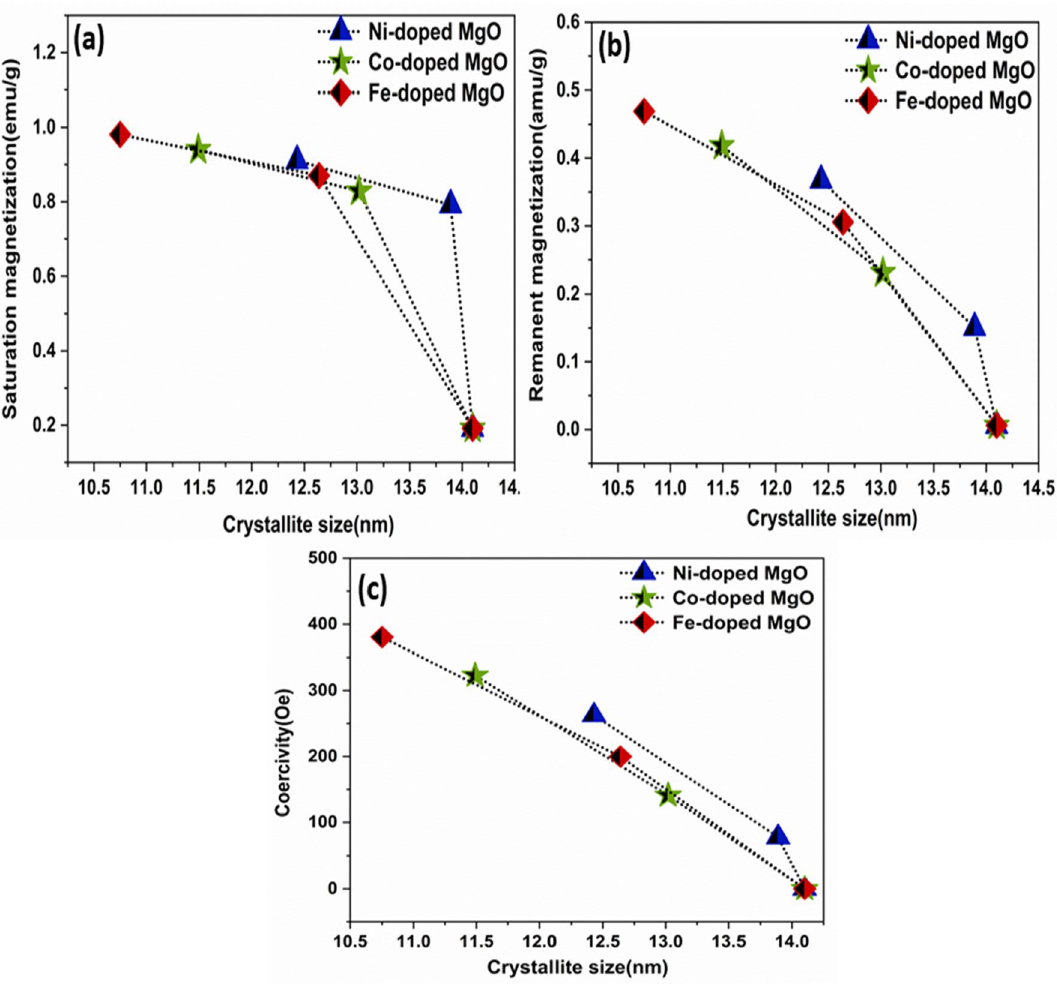
Figure 13. The Correlation between the crystallite size and ( a ) Ms, ( b ) Mr, ( c ) Hc of Ni , Co , and Fe-doped MgO nanoparticles with the various doping concentrations of 0%, 3% and A scale in mm was used to measure the inhibition zone diameters, which had appeared around each filter paper disc. At doses 20 and 30 μg/ml of nanoparticle suspensions, there was no inhibition zone against E. coli (gram-negative) and S. aureus (gram-positive). Still, the inhibition zone was observed around each filter paper disk against E. coli and S. aureus at dose 40 μg/ml of nanoparticle suspensions as shown in Figs. 15 and 16. The differences measured of inhibition zone diameter around the filter paper disk might be attributed to many factors such as the amount of the nanoparticle concentrations suspension, size of nanoparticles, the type of the materials, and resistance of bacteria on antibacterial. The average inhibition zone diameter at 40 μg/ml and 80 μg/ml of Ni, Co, and Fe-doped MgO nanoparticles against E. coli were listed in Tables 4 and 5, respectively, as shown in Figs. 17 and 18. The values of the average diameter of the inhibition zone against S. aureus were listed in Tables 6 and 7 and shown in Figs. 17 and 18. The results of the effect of Ni, Co, and Fe-doped MgO nanoparticles on E. coli and S. aureus at 40 μg/ml and 80 μg/ml showed better activity with gram-negative bacteria ( E. coli ) than gram-positive bacteria ( S. aureus ). These results are possible because S. aureus bacteria possess a high resist- ance, becoming resistant to many commonly used antibiotics. As noticeable from the readings in Tables 6 and 7, the inhibition zone diameter increased by increasing the concentration of doping ions. At 7% of transition metal (Ni, Co, and Fe)-doped MgO nanoparticles, the diameters of inhibition zone bigger than the diameter of inhibition zone for 1% of transition metal (Ni, Co, and Fe)-doped MgO nanoparticles. Moreover, 7% Fe-doped MgO nanoparticles exhibit the best bactericidal effect at a 80 μg/ml concentration. Pour plate technique. The pour plate technique was used to count the total number of colony-forming bacteria present in the liquid media. We used the mixed samples of nanoparticles colloidal suspension and bacterial suspension in this technique. First, liquid and solid nutrient bacterial growth media were prepared and sterilized for 60 min at 121 °C in an autoclave. After using autoclave, the nutrient broth medium was kept for a few minutes under room temperature till it became cool. Then it was inoculated by E. coli and S. aureus in separate test tubes and incubated for 24 h at 37 °C. The serial dilution was prepared up to 10 –4 of CFU to reduce bacterial suspension concentration. The bacterial suspensions were inoculated using nanoparticles colloidal sus-